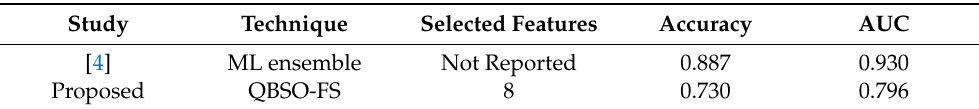
Table 11. Proposed model comparative analysis with the current state-of-the-art methods using the cardiovascular